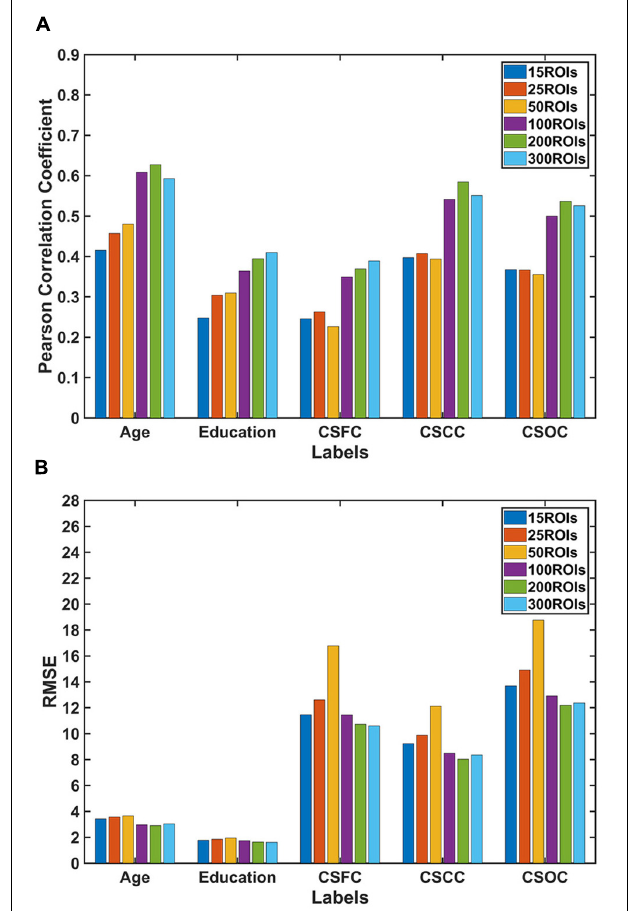
FIGURE 4 | The influence of the number of latent variables on the estimations. The reported values were (A) Pearson correlation coefficient and (B) RMSE. The number of latent variables ranged from 10 to 150. The results indicated that multi-label PLSR was relatively stable when the number of latent variables varied over a wide range (here, 10 ∼ 150).